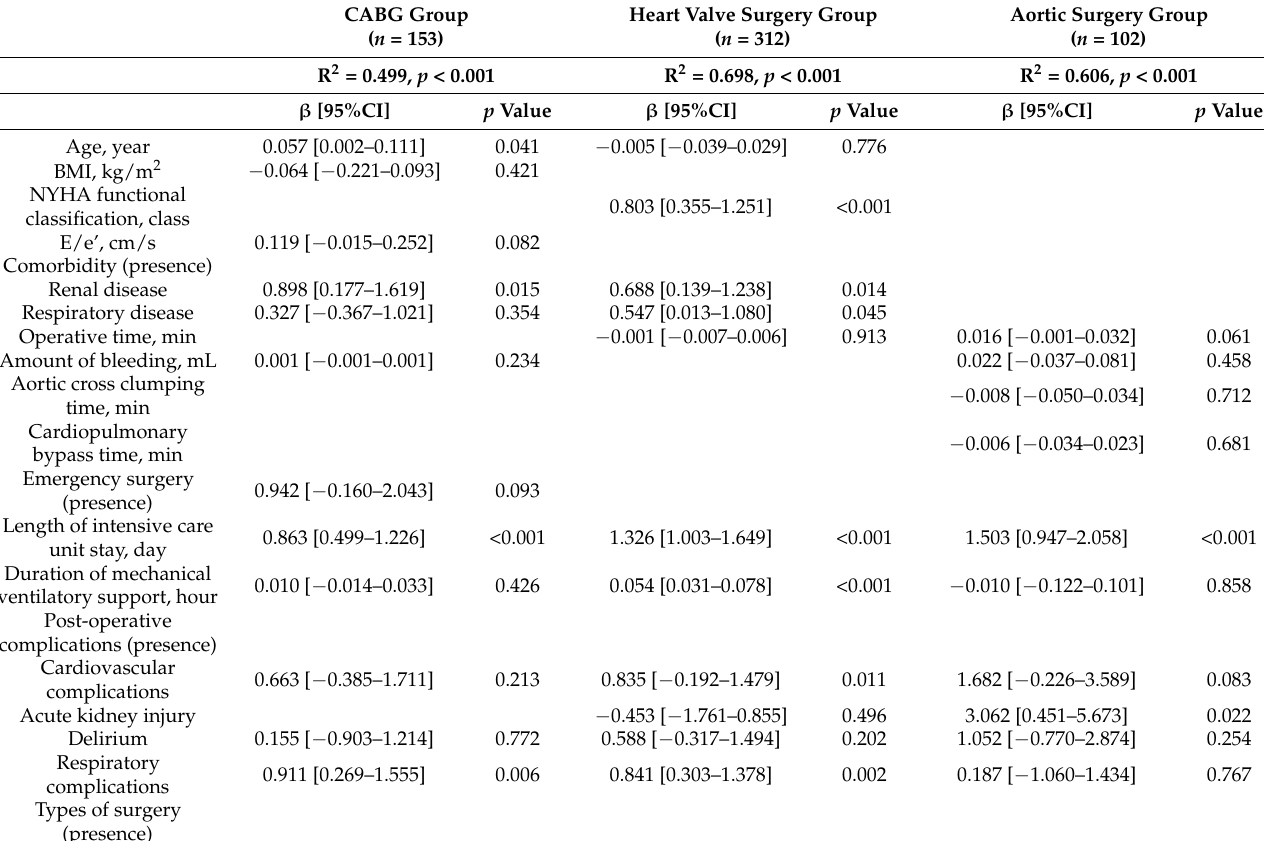
Table 3. Multiple liner regression analysis of determining factors for achieving of independent